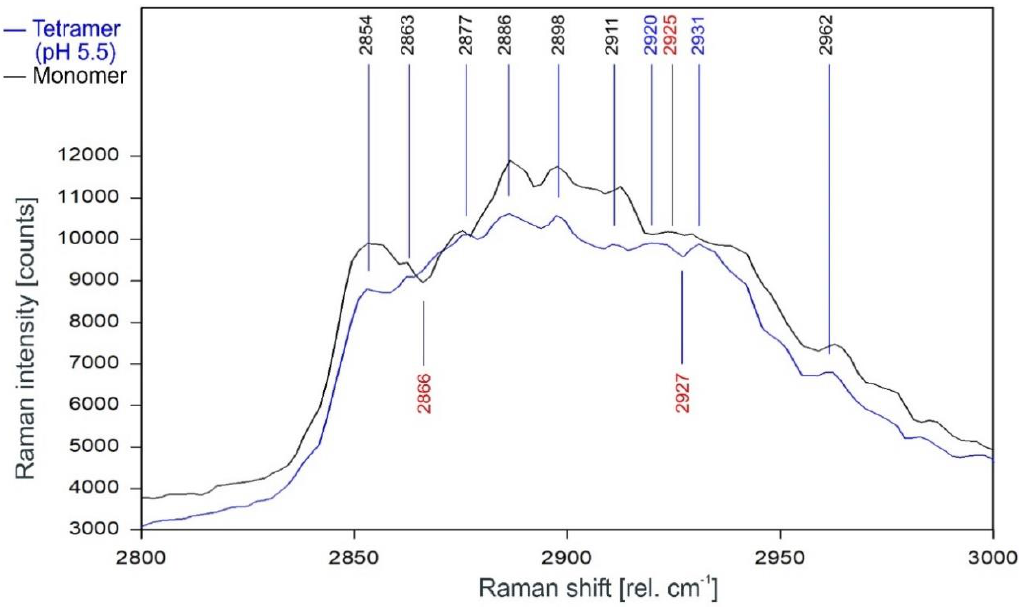
Figure 11. Comparison of the Raman spectrum of the open KcsA channel at pH 5.5 (blue) with the KcsA monomer (black) between 2800 and 3000 rel. cm − 1 as recorded.